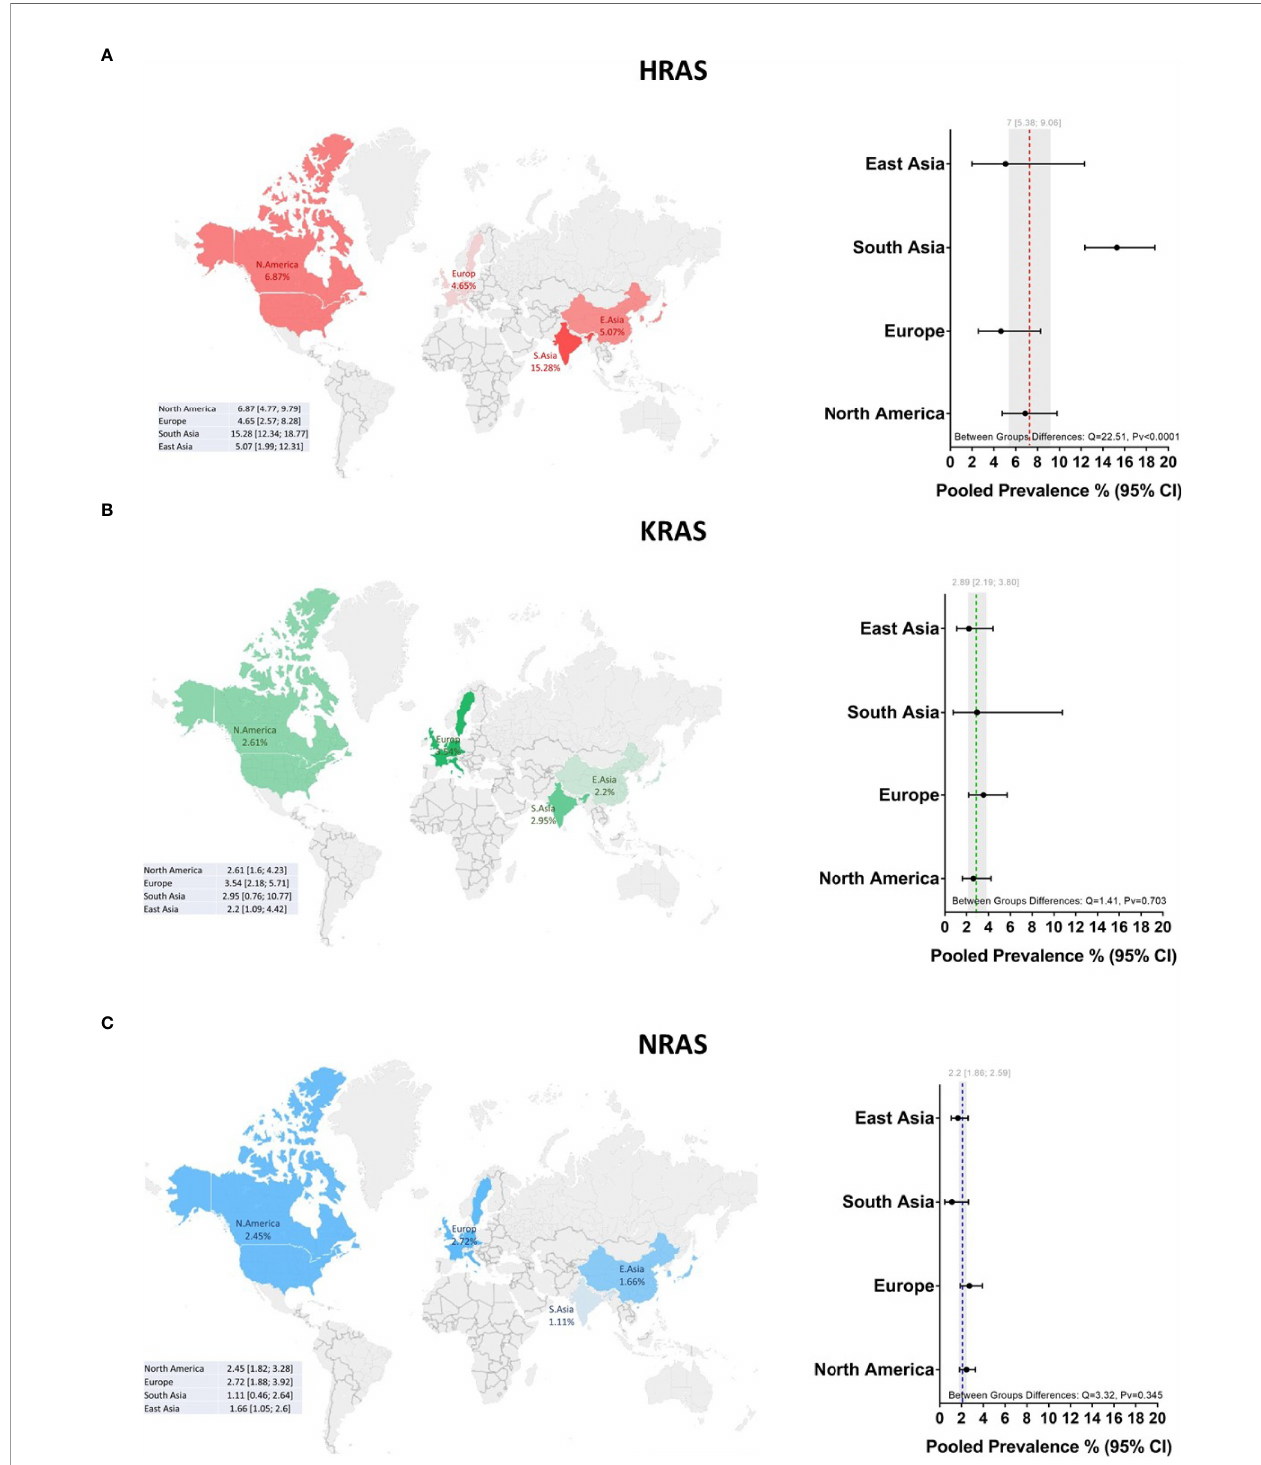
FIGURE 3 | Global prevalence of RAS mutations in head and neck cancer. Cohort studies were grouped according to the geographical origins of the patients. On the map of the world are shown the frequencies [%] of (A) HRAS, (B) KRAS, and (C) NRAS mutations in East Asia, South Asia, Europe, and North America. Dotted lines and gray shading correspond to the overall prevalence and the 95% CI. CI, Con fi dence interval; I 2 , Inconsistency